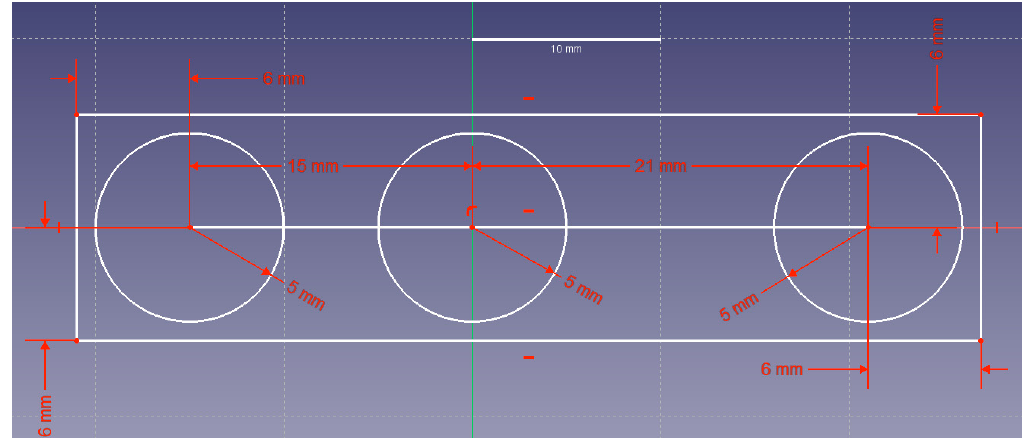
Figure 2. Drawing of the bearing surface for 10 mm pad diameter markers, the circles represent conductive material and are connected in 1 mm height.